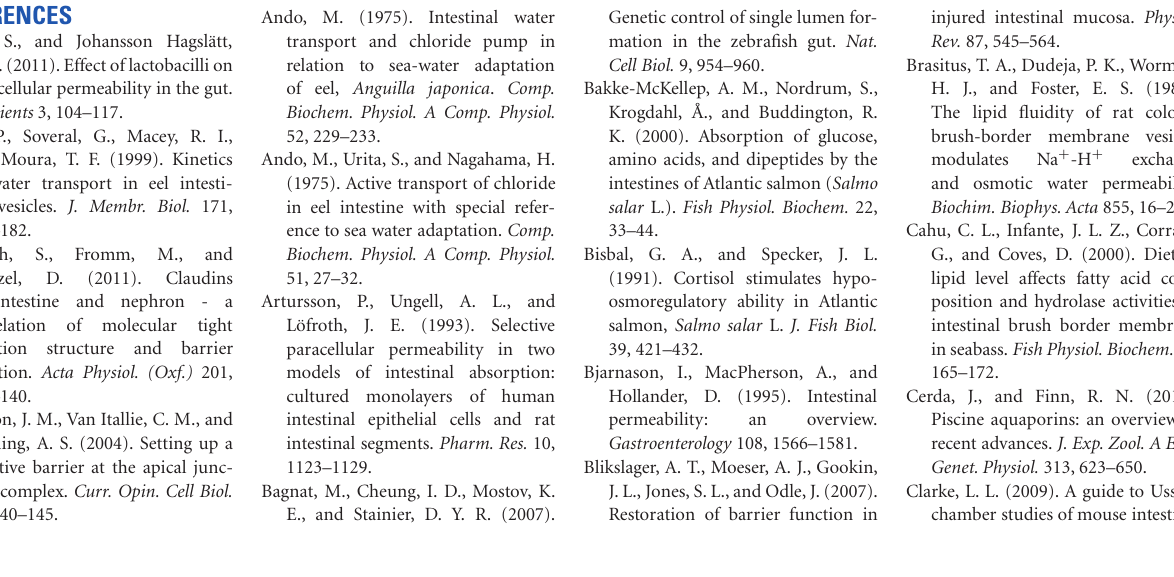
FIGURE 7 | A tentative model showing possible roles and positions of aquaporins (AQPs) and claudins in FW parr (A), during smoltification (B), and after acclimation to SW (C). In SW post- smolts, protein expression of AQPs 1aa, 1ab, and 8ab are present in the apical membrane, AQPs 1aa and 1ab in vesicles and AQP 8ab in the basolateral membrane (C) , with basis in these experiments and